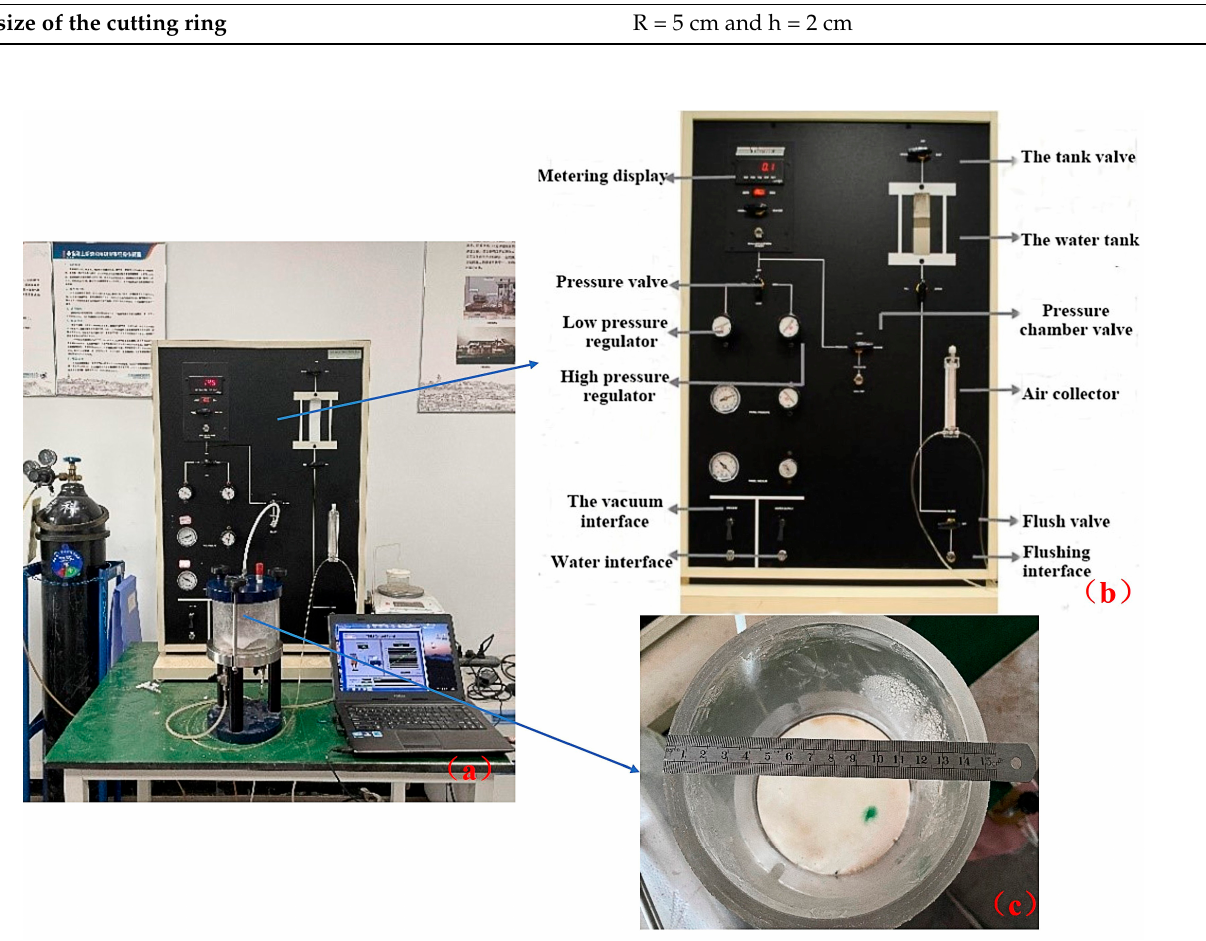
Figure 8. Saturated soil sample. Table 3. The operation flow of unsaturated soil transient in dehumidification and hygroscopic sys- tems. The system of saturated The clay plate, water storage area under the clay plate, gas collection cylinder, pipeline, and attached rubber hose should be saturated. Apply a certain amount of pressure and wait for the water to drain slowly into the collection bottle. Water filling